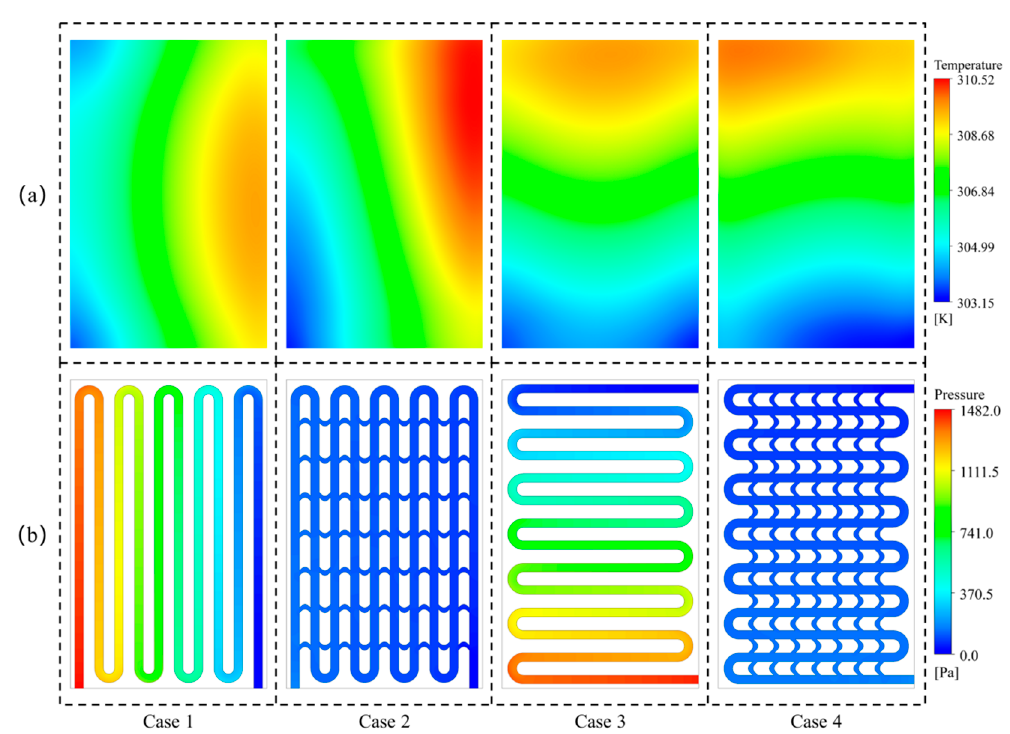
Figure 7. Thermal performances of different channel designs: ( a ) temperature contours across the battery central surface; ( b ) pressure contours of the channel central surface.